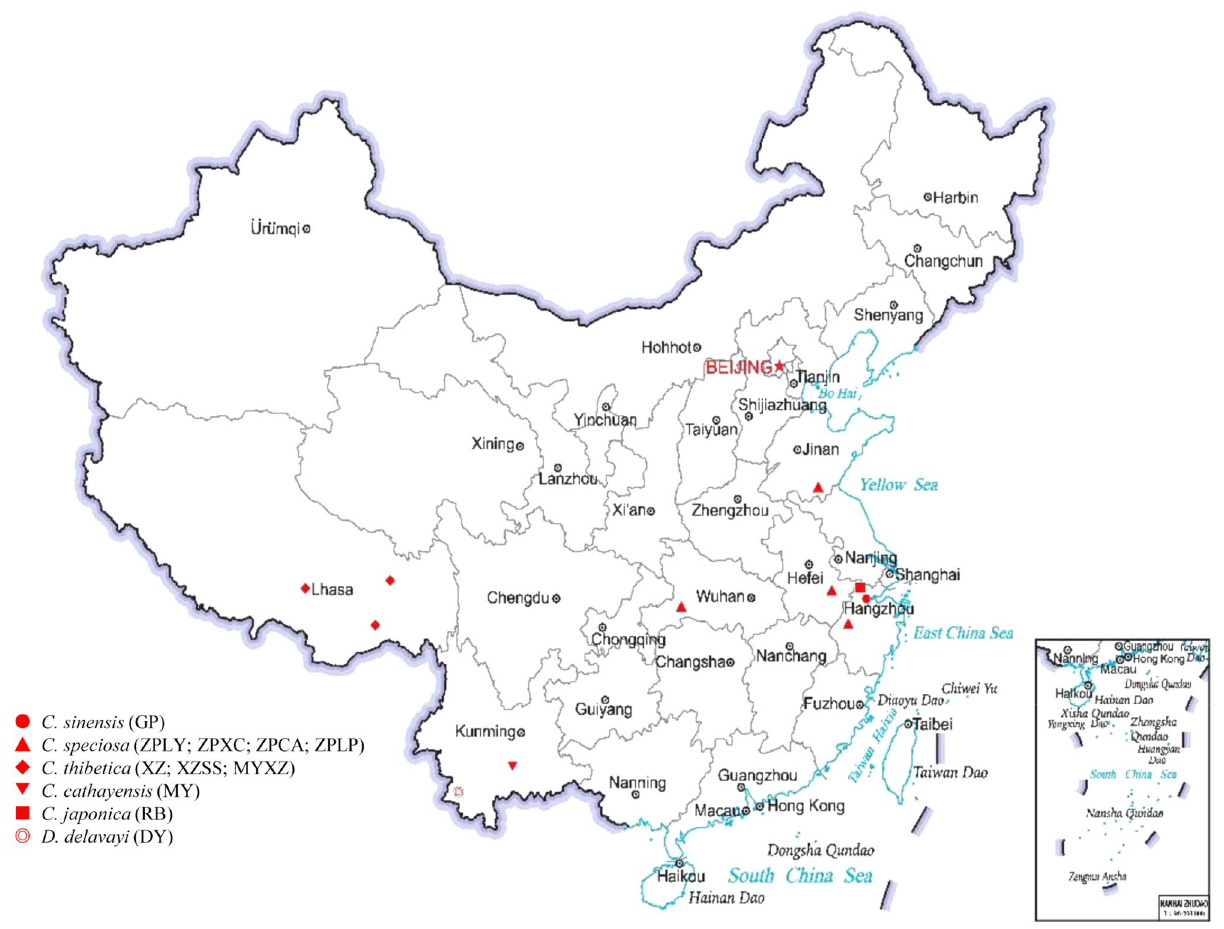
Figure 1. Distribution of the 11 germplasms used for the research in China. Different symbols represent different species. Each germplasm was labelled with specimen IDs as follow: C. sinensis (GP) (SWH190512), C. speciosa (ZPLY) (SWH190535), C. speciosa (ZPXC) (SWH190621), C. speciosa (ZPCA) (SWH190657), C. speciosa (ZPLP) (SWH190645), C. thibetica (XZ) (SWH190805), C. thibetica (XZSS) (SWH190823), C. thibetica (MYXZ) (SWH190837), C. cathayensis (MY) (SWH190711), C. japonica (RB) (SWH190527), and D. delavayi (DY) (SWH190726). All of the germplasms were identified by Professor J.M.J. The map was downloaded on https:// www. tiand itu. gov.